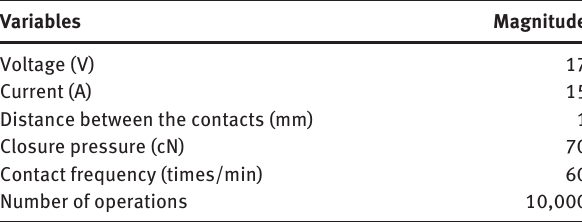
Table 2 Parameters of arc erosion